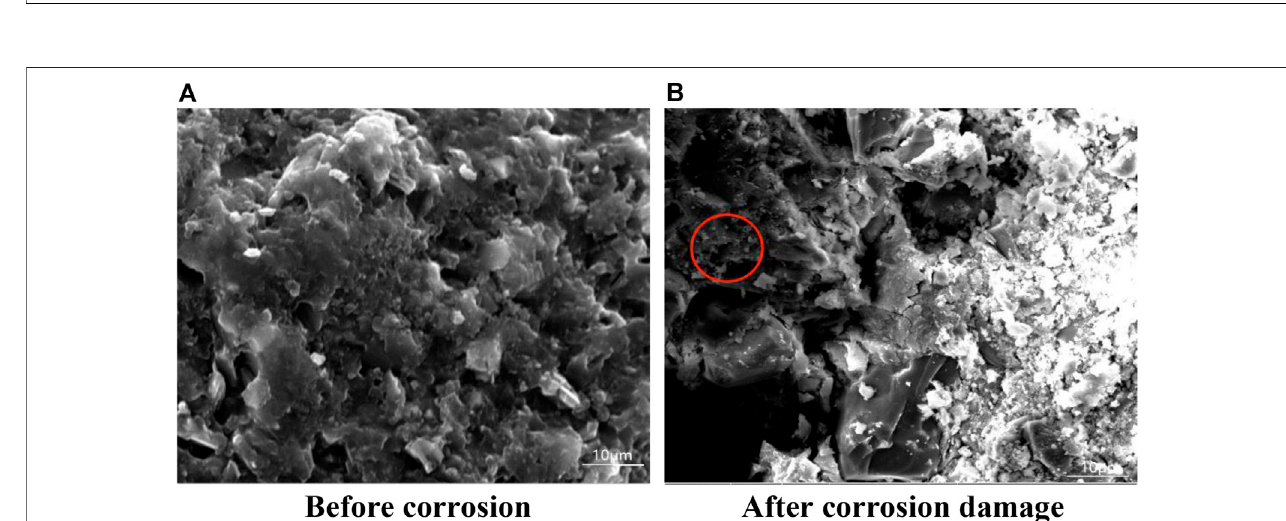
FIGURE 4 | SEM images of C50-0 concrete before and after sulfate